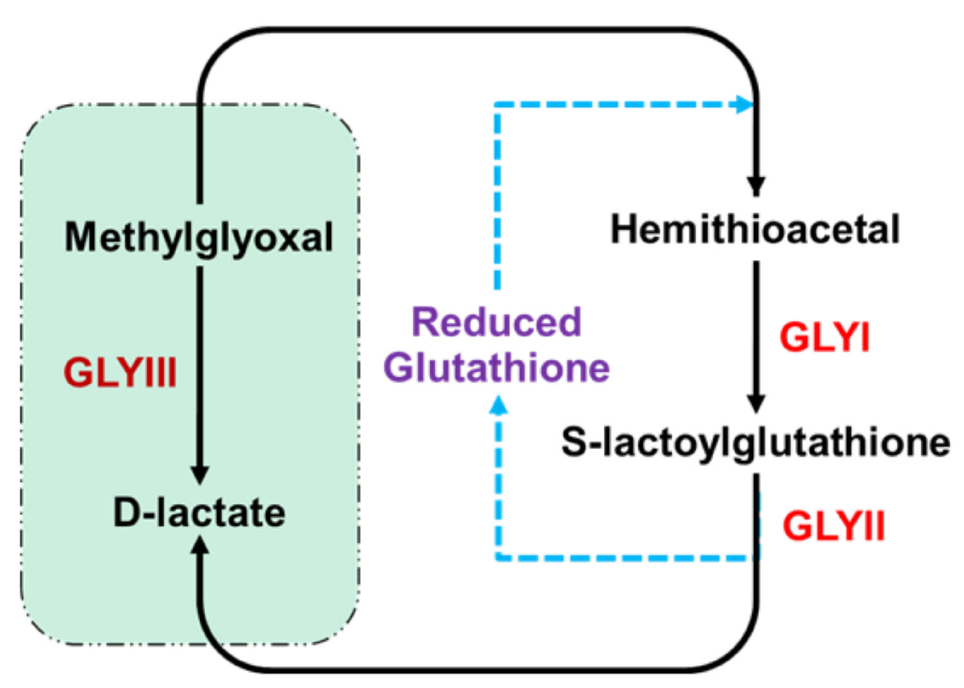
Figure 1. The glyoxalase pathway for metabolism of methylglyoxal. The classical two-step glyoxalase pathway converts methylglyoxal (MG) to D-lactate with the help of Glyoxalase I (GLYI) and Gly- oxalase II (GLYII) enzymes and uses reduced glutathione (GSH) as cofactor. Glyoxalase III (GLYIII) constitutes the shorter pathway of MG detoxification which directly converts MG to D-lactate in a single step, without involving